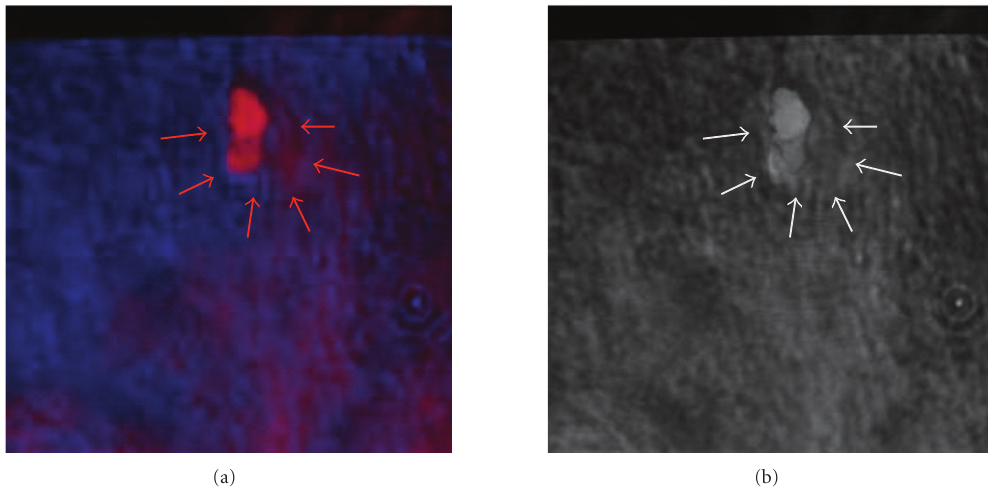
Figure 6: The fused breast image using the primary breast image with fibroadenoma as shown in Figure 5 by (a) color-based method; (b) pixel-level method with R = 50%.